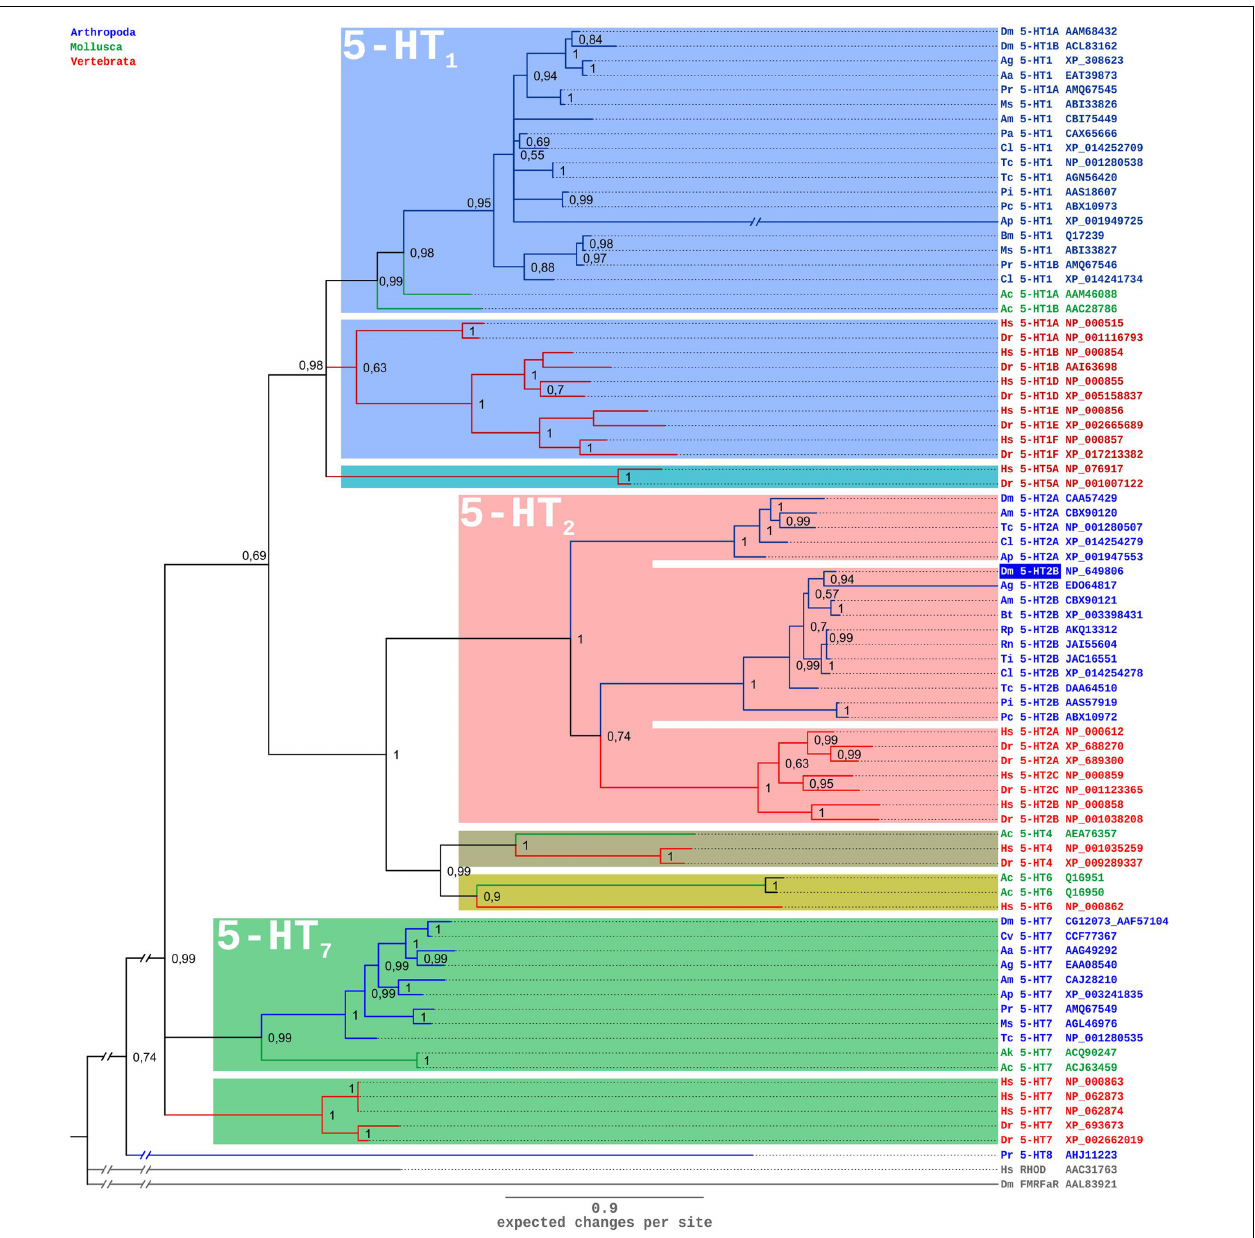
FIGURE 3 | Bayesian phylogeny of 5-HT receptors. Alignments were performed using Clustal W (Thompson et al., 1994) by using the core amino-acid sequences lacking the variable regions of the N- and C-terminus and the third cytoplasmic loop. Human rhodopsin (Hs RHOD) and D. melanogaster FMRFamide receptor (Dm FMRFaR) were used to root the tree. Numbers at branches represent the posterior probabilities. Receptor subclasses are highlighted by distinct colors. Abbreviations of species in alphabetical order: Aa Aedes aegypti , Ac Aplysia californica , Ag Anopheles gambiae , Ak Aplysia kurodai , Am Apis mellifera , Ap Acyrthosiphon pisum , Bm Bombyx mori , Bt Bombus terrestris , Cv Cimex lectularius , Cv Calliphora vicina , Dm Drosophila melanogaster , Dr Danio rerio , Hs Homo sapiens , Ms Manduca sexta , Pa Periplaneta americana , Pc Procambarus clarkii , Pi Panulirus interruptus , Pr Pieris rapae , Rn Rhodnius neglectus , Tc Tribolium castaneum , Ti Triatoma infestans.